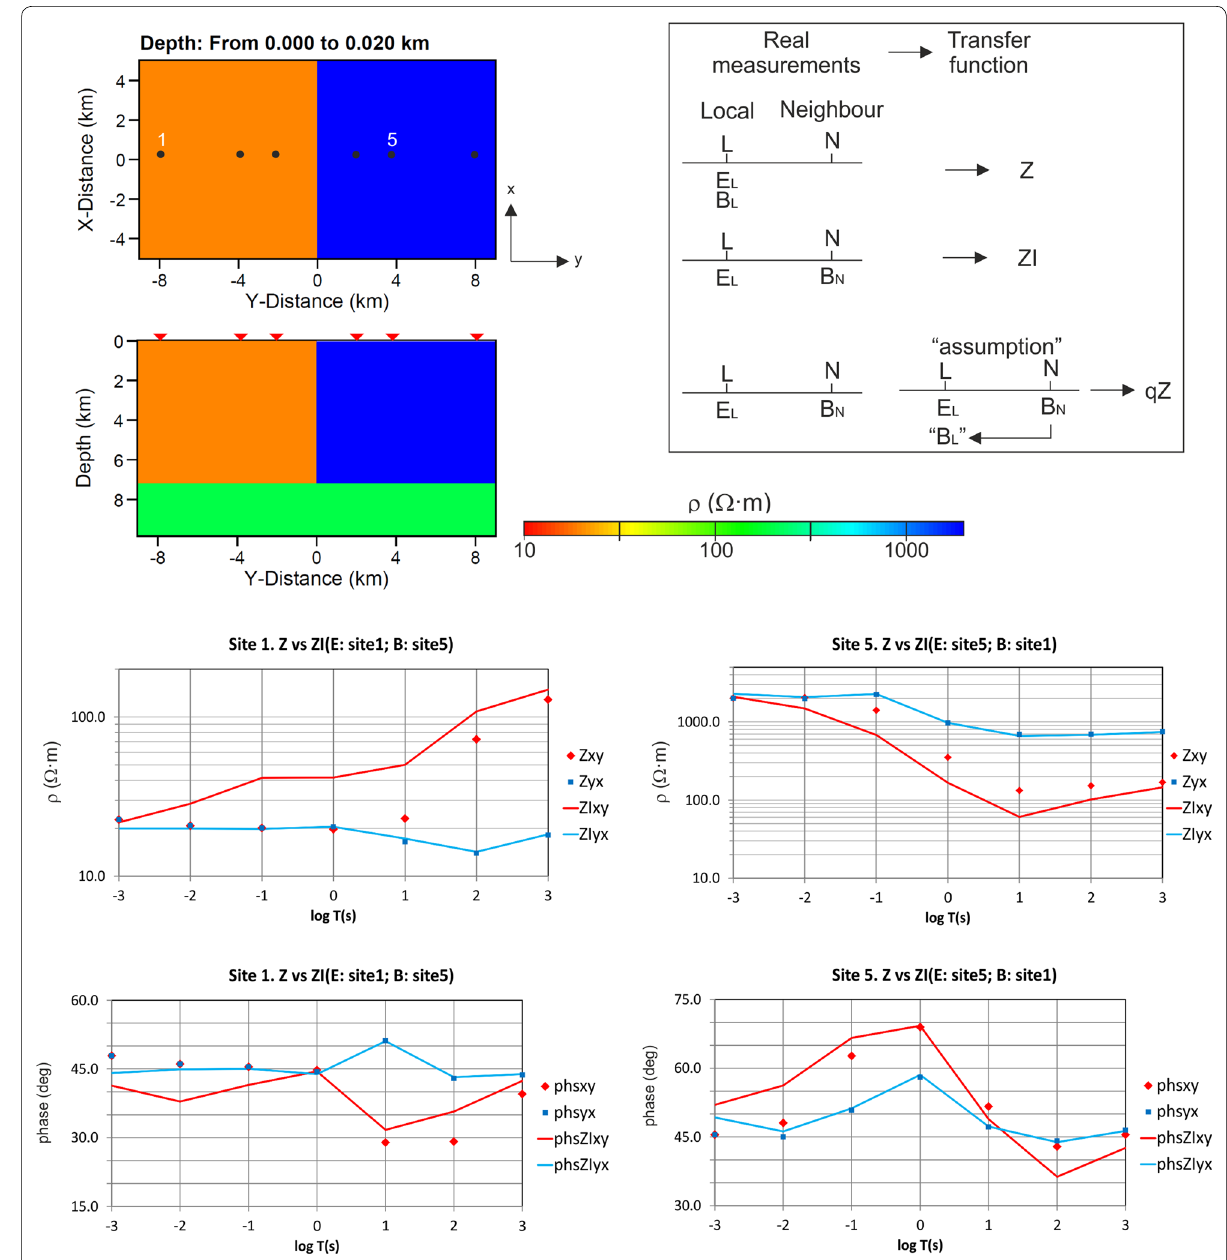
Fig. 2 Top: plan view of the top layer and cross section of Model 1 (central part). Site positions are indicated with circles and triangles, and labels 1 and 5 identify the sites used as magnetic references. The diagram in the top right box indicates the configurations to obtain Z , ZI and qZ. Bottom: apparent resistivity and phases obtained for this model from the impedances Z (squares and diamonds), and from the interstation impedances ZI (continuous lines), for Site 1 and Site 5. Note that each site has different apparent resistivity and phase